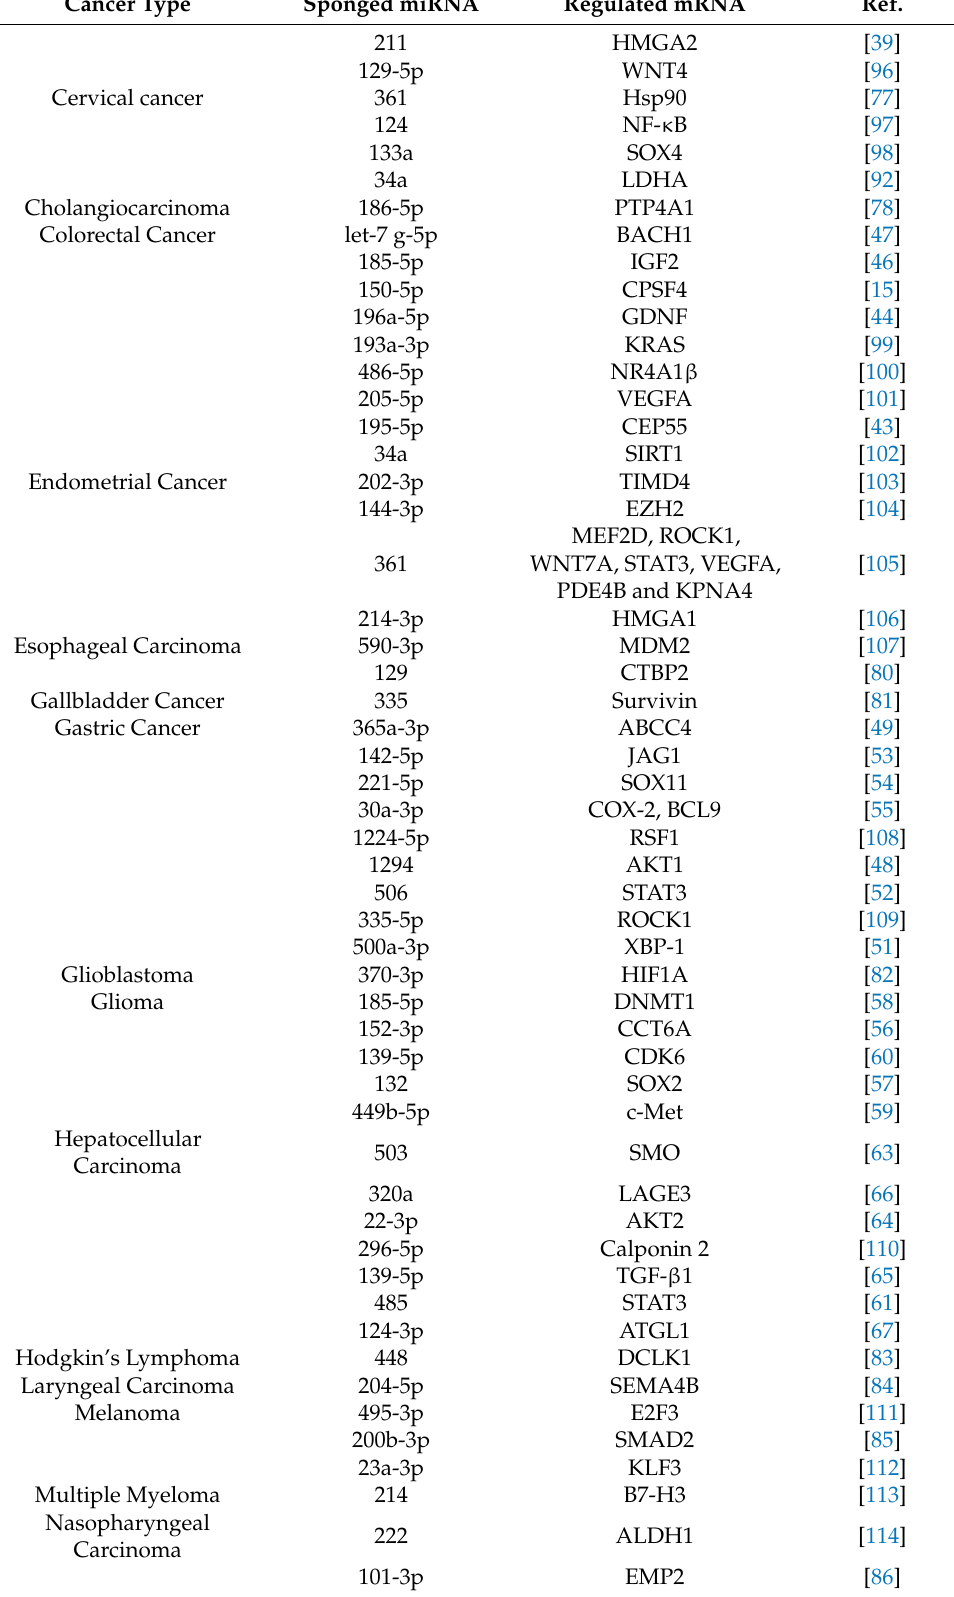
Table 1. Cont. Cancer Type Sponged